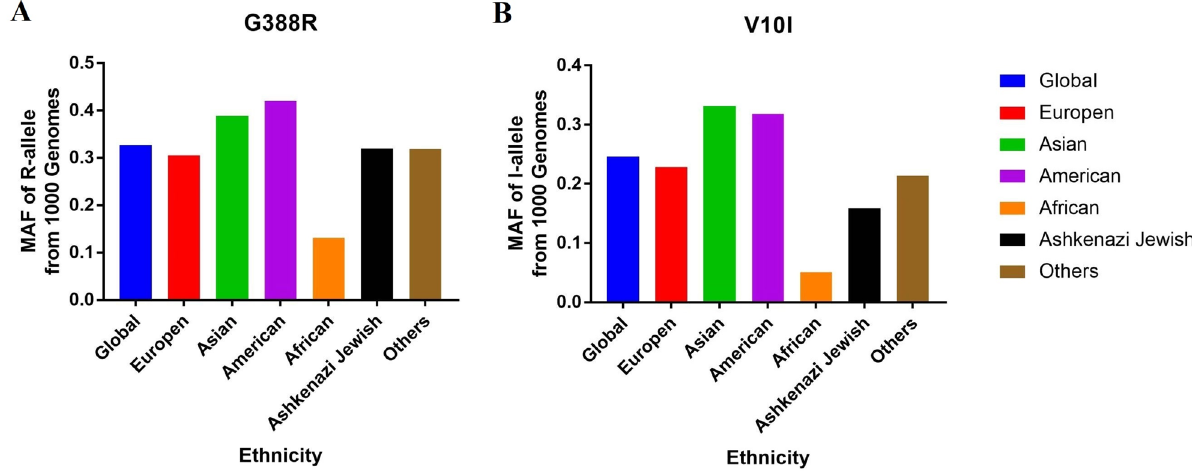
Figure 1. Minor allele frequencies of FGFR4 G388R ( A ) and V10I ( B ) variants in various